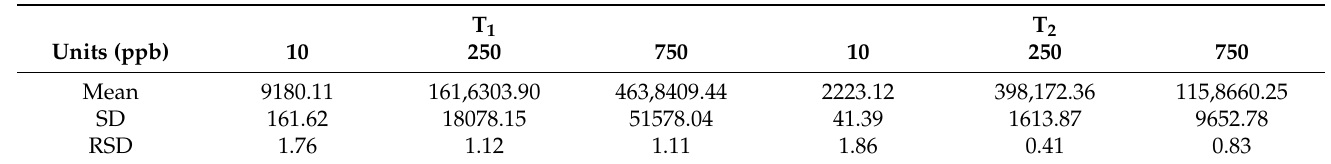
Table 1. Repeatability of the method for two transitions (T 1 and T 2 ) expressed as mean, standard deviation (SD) and relative standard deviation (RSD), for three different concentration levels (10, 250 and 750 ppb). T 1